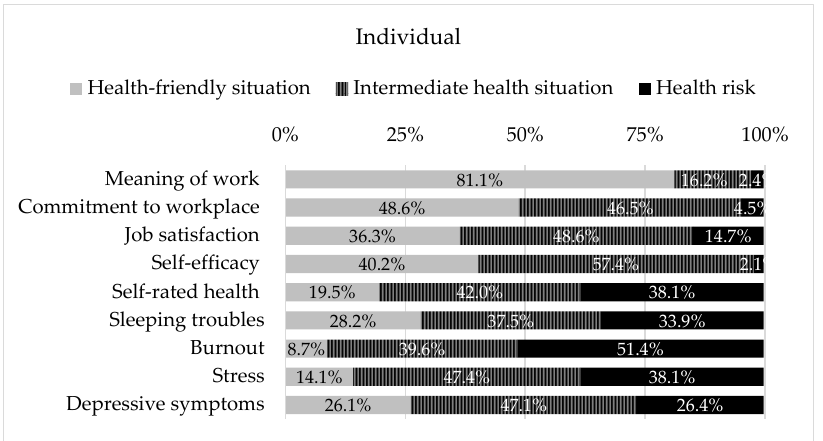
Figure 3. PRFs framed in the element of Individual, of work system of the SEIPS 3.0 model, and the respective health risk that the exposure represents.